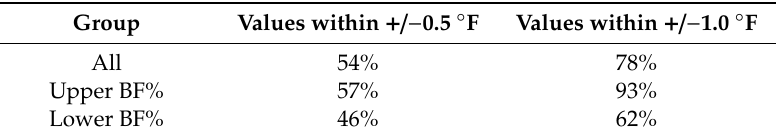
Figure 6. Histogram plots for Upper BF% (left) and Lower BF% (right) groups, where the percent of total observations (Y-axis) is plotted against given ranges of error (X-axis). Table 7. Histogram values for Figure 6.